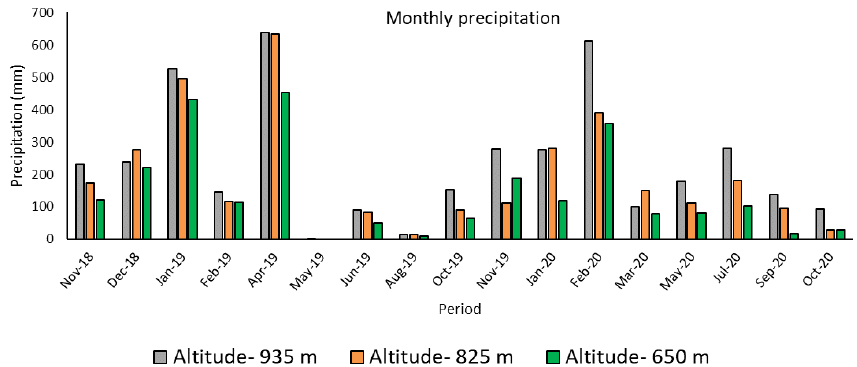
Figure 1. Monthly precipitation rainfall values obtained from pluviometers installed at three altitudes (935 m, 825 m, 650 m) in the experimental area of Gorongosa Mountain.